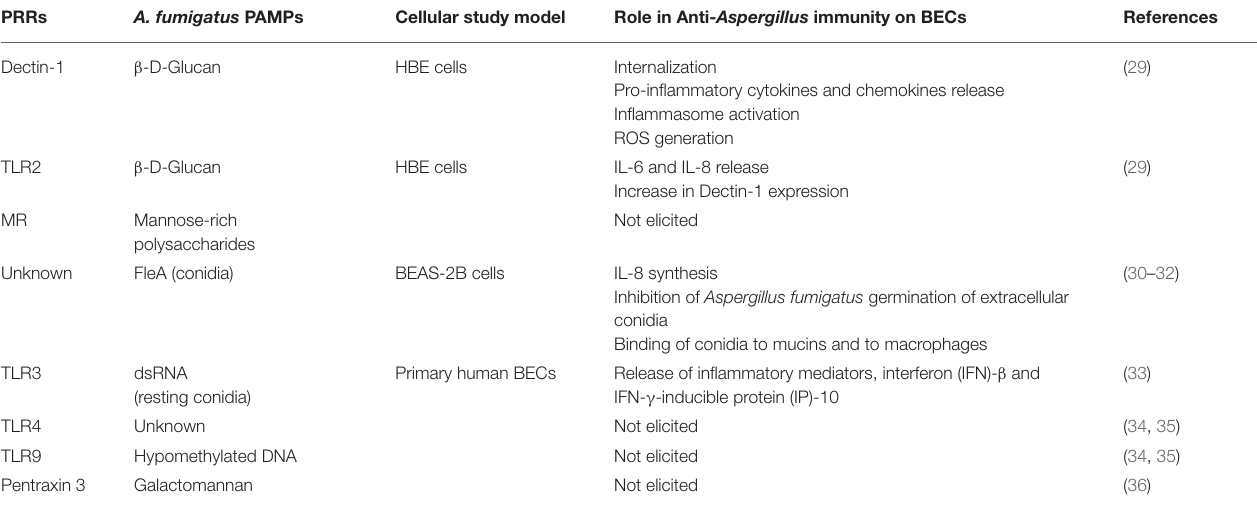
TABLE 1 | Pattern recognition receptors (PRRs) and pathogen-associated molecular patterns (PAMPs) involved in the recognition of Aspergillus fumigatus by bronchial epithelial cells and the consequences of their activation.